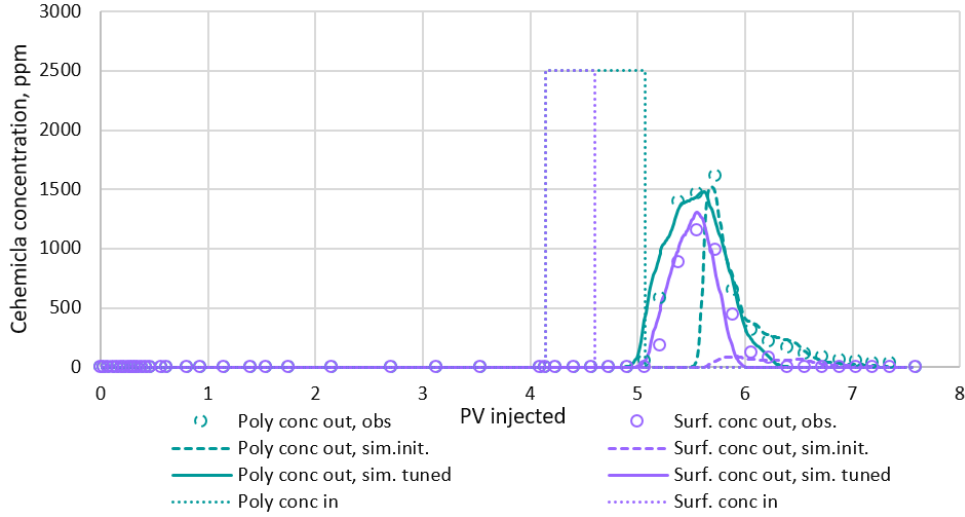
Figure 15. Result of model tuning to experimental data (displacement parameters).